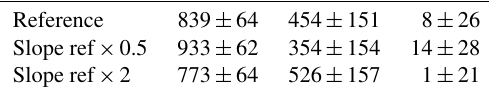
Table 7. Interannual mean and SD of simulated evapotranspiration (ET), streamflow ( Q ) and storage ( S ) for the period 2007–2012 for the reference case and two extreme slope